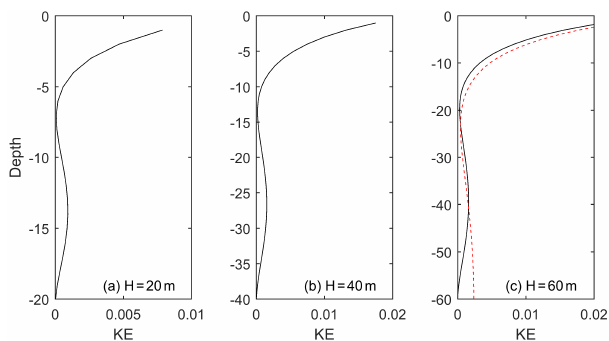
Figure 13. Vertical profile of averaged inertial kinetic energy for the homogeneous cases with water depths of 20, 40, and 60m. The red dashed line in (c) denotes the slip